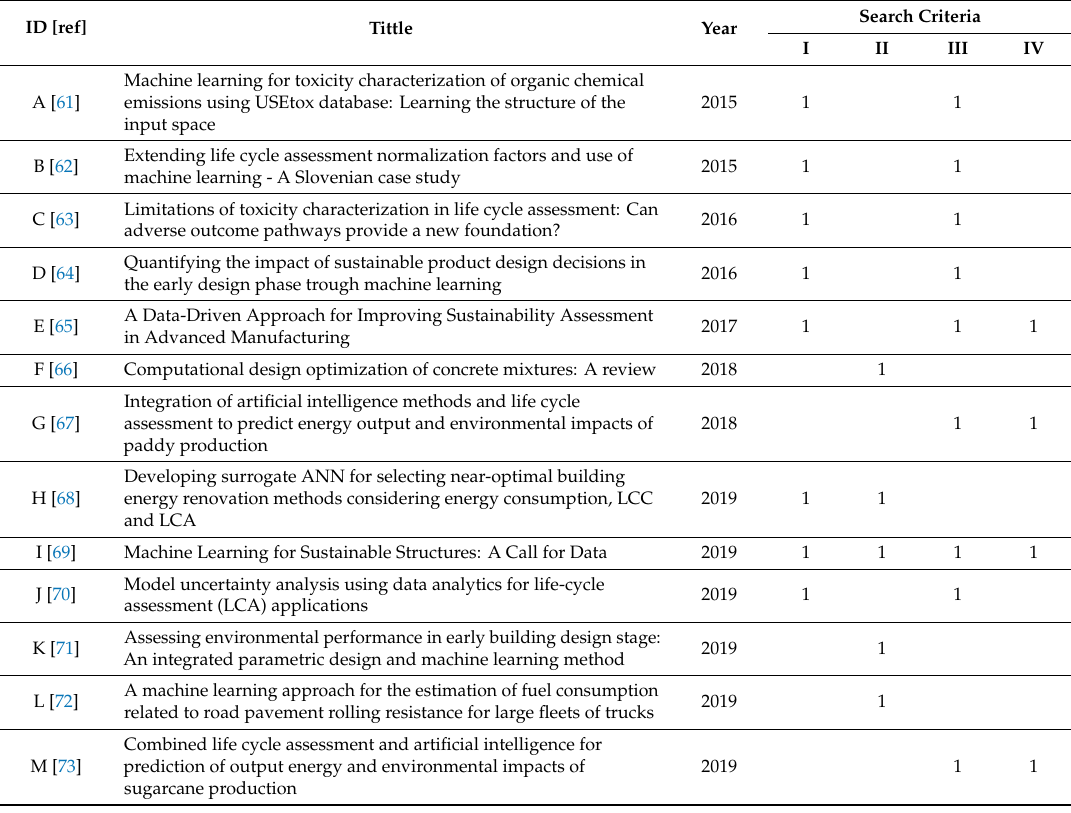
Table 2. Documents used to construct the conceptual